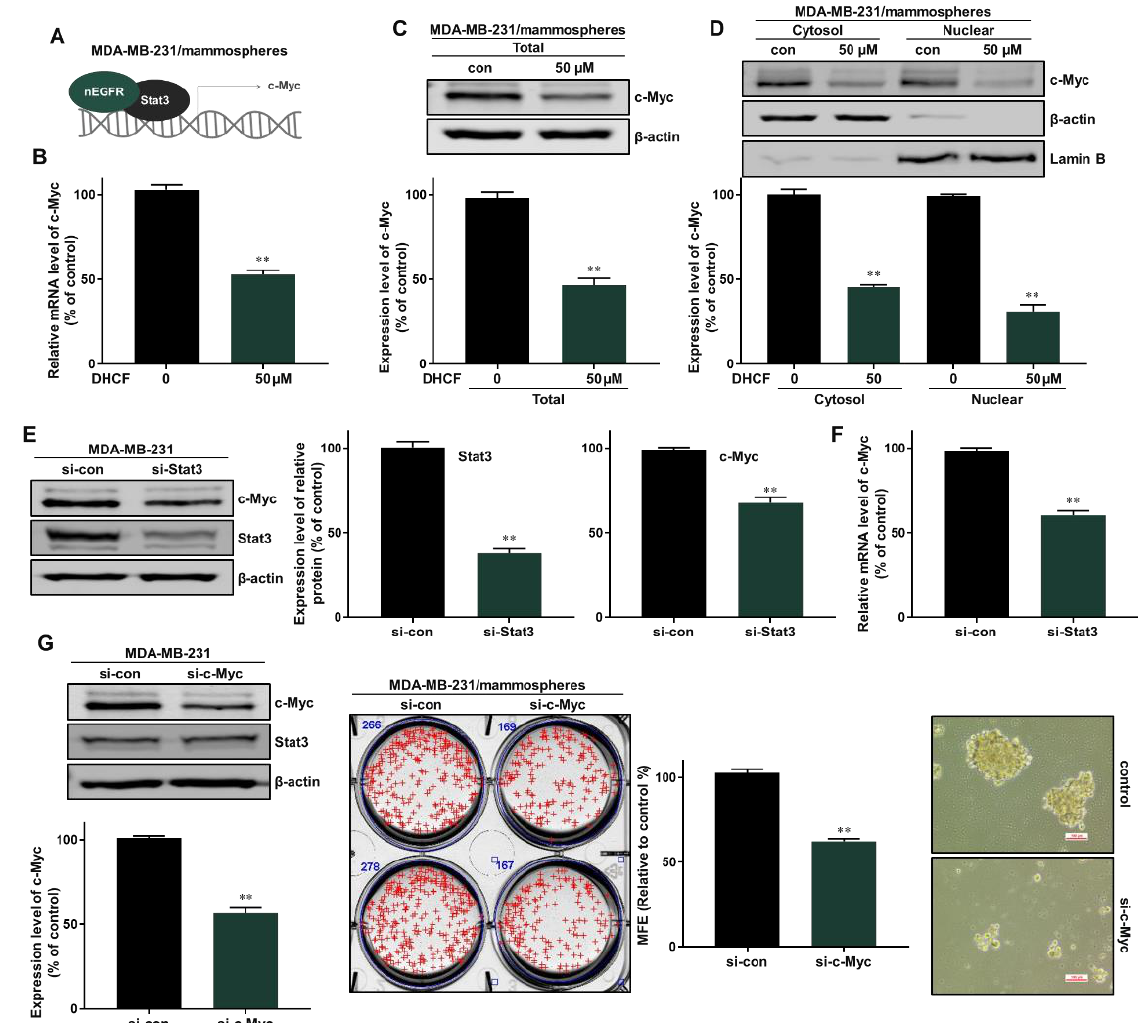
Figure 7. Dihydroconiferyl ferulate inhibits the c-Myc pathway via Stat3/nEGFR. ( A , B ) The relative mRNA levels of c-Myc were measured in mammospheres after treatment with dihydroconiferyl ferulate (50 µ M) for 48 h. Dihydroconiferyl ferulate reduces the mRNA levels of c-Myc. ( C ) The expression level of c-Myc in total protein from MDA-MB-231 mammospheres treated with dihydroconiferyl ferulate (50 µ M) for 48 h. Dihydroconiferyl ferulate reduces the expression of c-Myc. ( D ) The nuclear protein level of c-Myc was determined in mammospheres derived from MDA-MB-231 cells treated with dihydroconiferyl ferulate (50 µ M) for 48 h. Dihydroconiferyl ferulate decreases the level of c-Myc in mammospheres. ( E ) The protein levels of Stat3 and c-Myc in MDA-MB-231 cells treated with a specific Stat3 siRNA. Knockdown of Stat3 decreased the expression of c-Myc. ( F ) qRT-PCR analysis of c-Myc in MDA-MB-231 cells treated with a specific Stat3 siRNA. ( G ) The protein levels of Stat3 and c-Myc in MDA-MB-231 cells treated with a specific c-Myc siRNA. Knockdown of c-Myc does not affect the expression of Stat3. Knockdown of c-Myc inhibits mammosphere formation. Representative data were collected and the data represent the mean ± standard deviation; ** p < 0.01 vs. control.